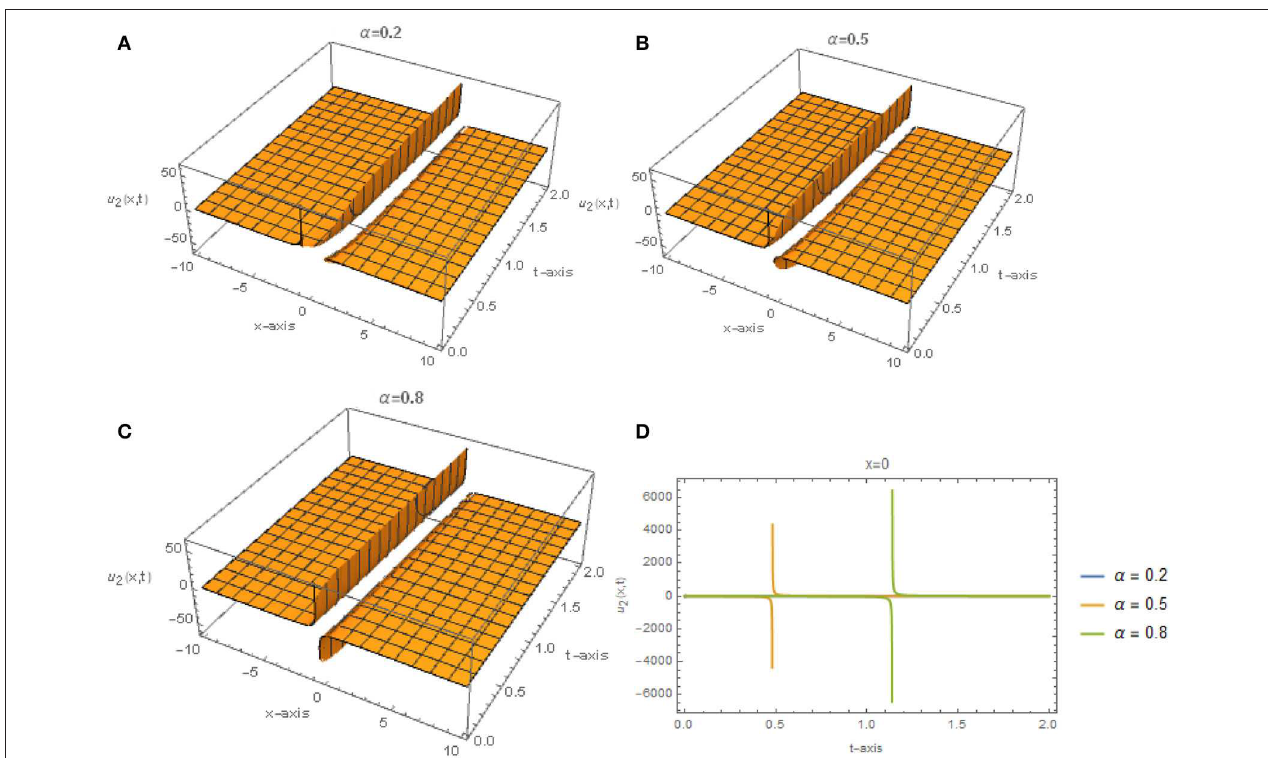
FIGURE 3 | (A–D) The Solution u_2 (x,t) given by Eq.